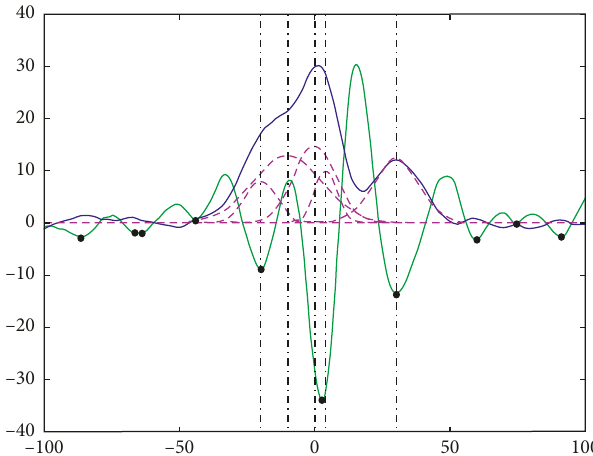
Figure 15: Second derivative applied to the same spectrum as Figure 14, with the introduction of noise, and then, a Savitzky– Golay smoothing is applied.